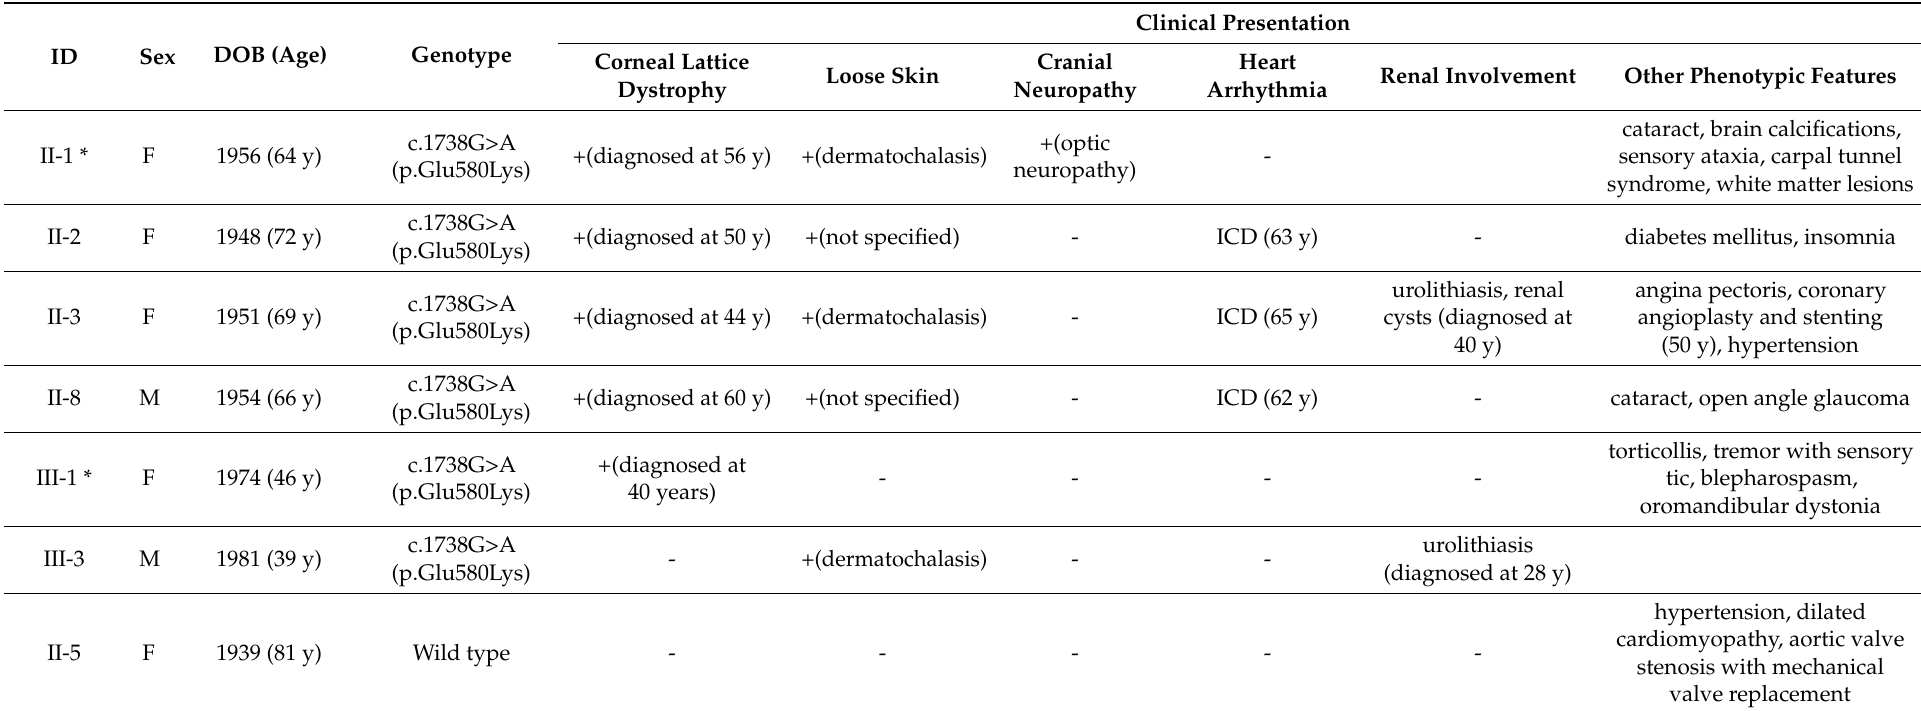
Table 1. The clinical presentation of the studied family